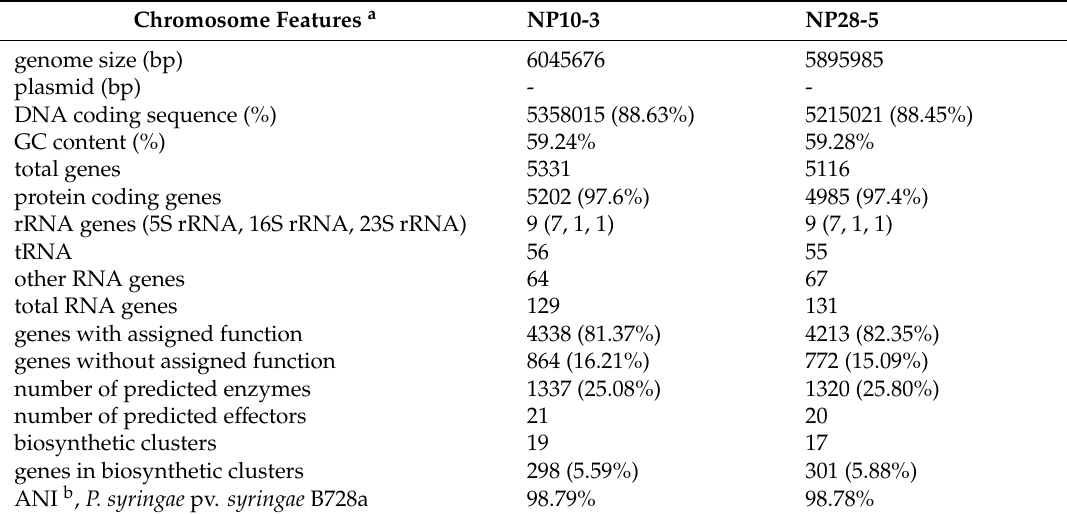
Table 2. General features of the Pseudomonas syringae NP10-3 and NP28-5 genomes.